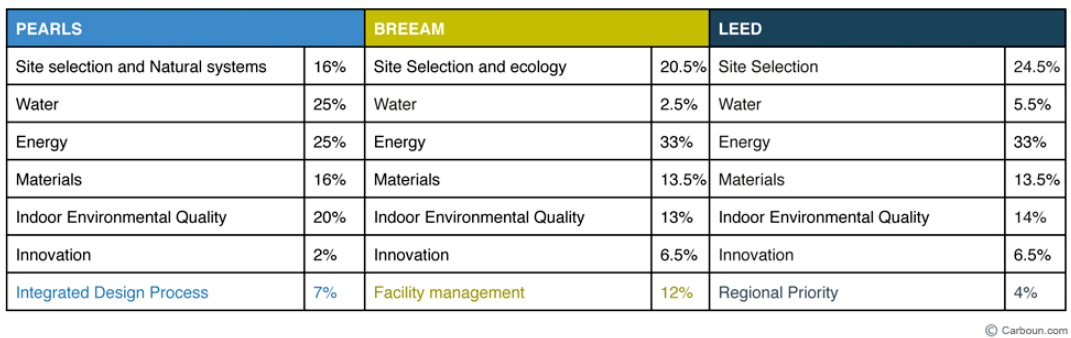
Figure 2. Rating systems comparison table. The table is for general comparison purposes only, as it does not take point-less prerequisites into account. The names of some categories have been adjusted and some credits have been moved across categories to simplify the